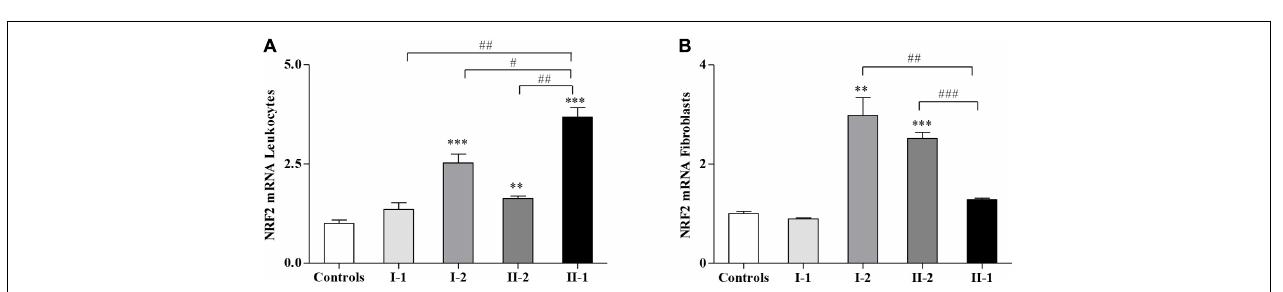
FIGURE 2 | Glutathione-related genes in Friedreich’s ataxia (FRDA) family. The expression of glutamate–cysteine ligase ( GCL ) and glutathione S-reductase ( GSR ) was analyzed by quantitative real-time PCR (qRT-PCR), respectively, in leukocytes (A,C) and fibroblasts (B,D) of the I-1, I-2, II-2, and proband II-1. Values represent median ± SEM. Statistical significance was defined as * p < 0.05, ** p < 0.01, *** p < 0.001 with respect to the controls and ## p < 0.01 compared with proband II-1.